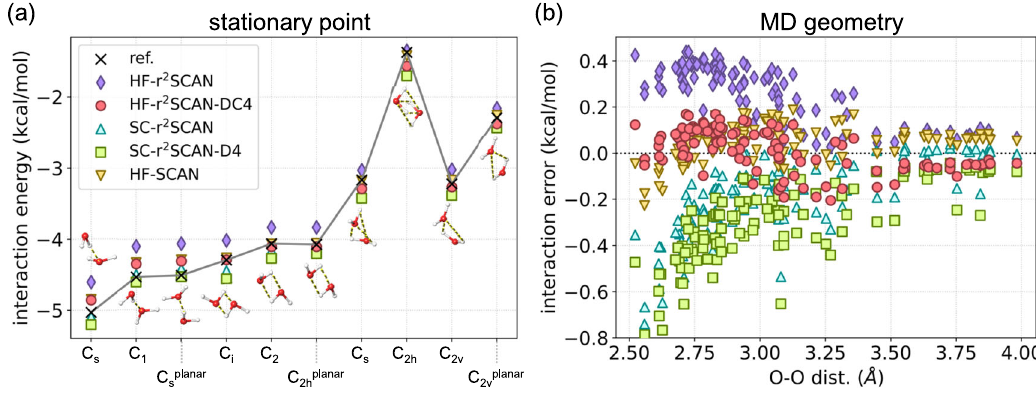
Fig. 2 | Water dimer interaction energies. a Smith stationary points 73 and b MD simulated water dimers with the oxygen-oxygen distance. For a , MAEs of each functional are (following the order in the legend) 0.25, 0.11, 0.09, 0.17, and 0.08kcal/mol. DLPNO-CCSD(T)-F12 has been used as a reference. For b , MAE of